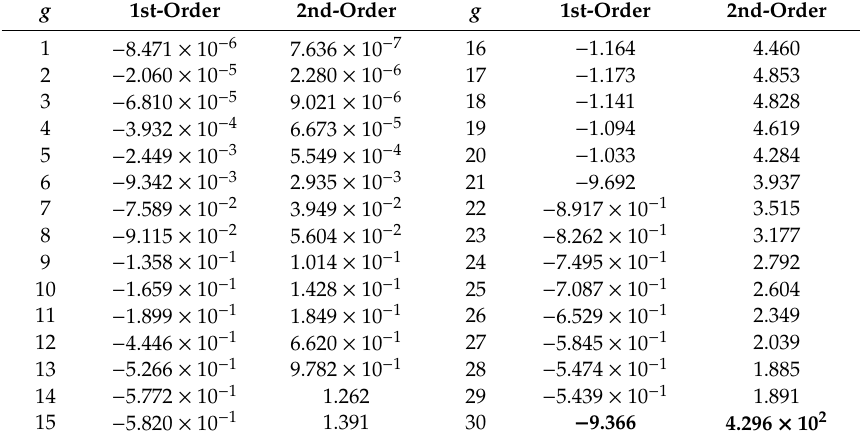
(cid:16) (cid:17)(cid:16) (cid:17) ∂ L / ∂σ g σ g , g = 1, ... ,30 and / L t , i = 6 t , i = 6 (cid:17)(cid:16) (cid:17) ∂σ g σ g σ g / L , g = 1, ... ,30, for isotope 6 ( 1 H). t , i = 6 t , i = 6 t , k = 6 t , k = 6